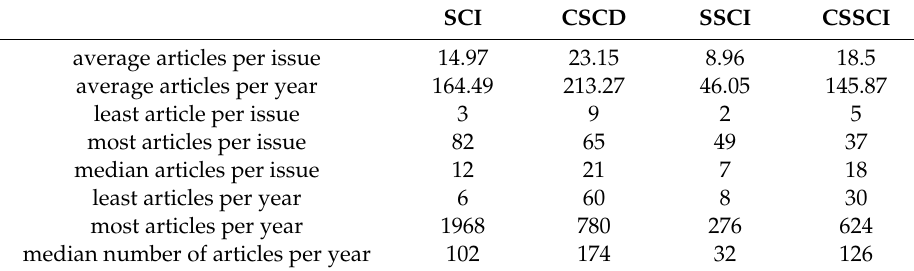
Table 4. Trimmed average of sample data from SCI, SSCI, CSCD, and